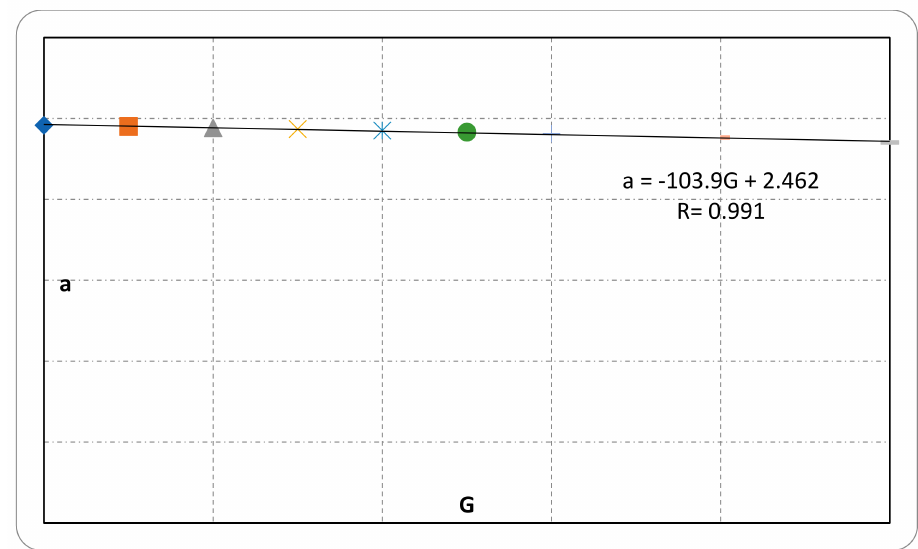
Figure 6. Relationship between coefficient a and the starting pressure gradient.